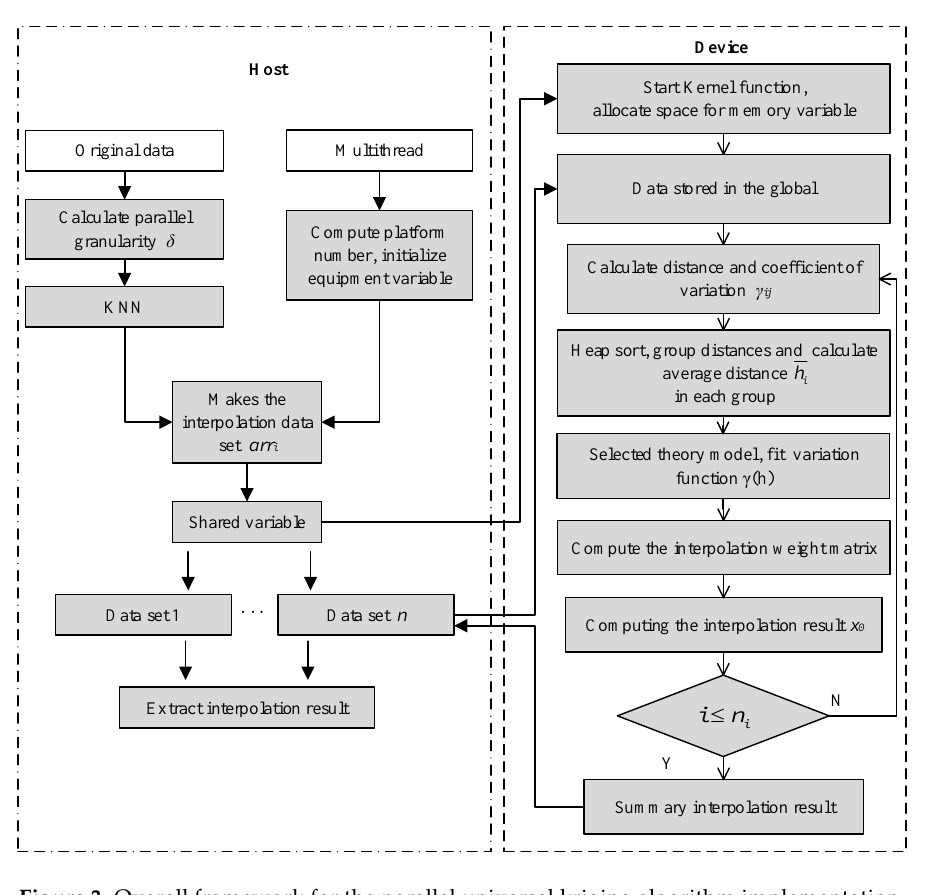
Figure 3. Overall framework for the parallel universal kriging algorithm implementation.